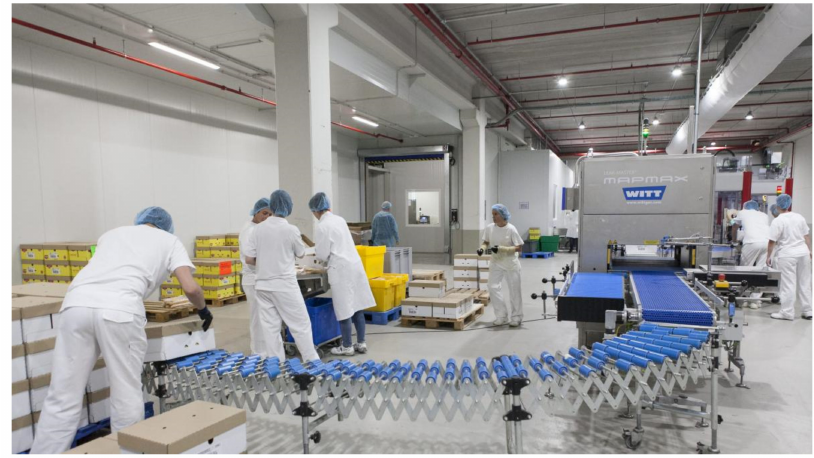
Figure 13. Non-destructive 100% control of packaging tightness, in-line device Leak Master MAPMAX ® , reprinted with permission from WITT